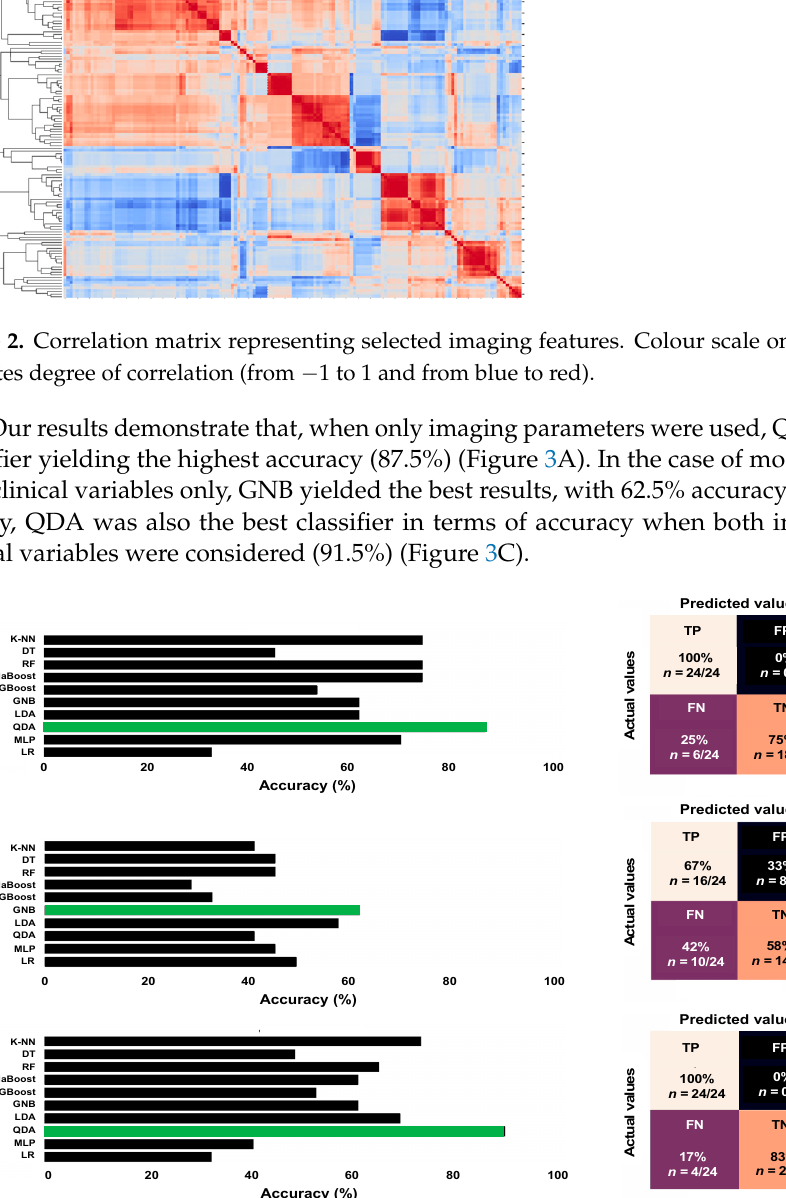
Table 4. Performance metrics of the different predictive models. Only metrics for the classifier providing the best results for each of the models are detailed. Predictive Models Performance